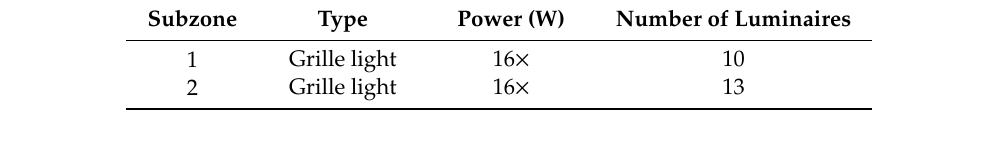
Figure 11. Comparison of dimming levels of a luminaire.